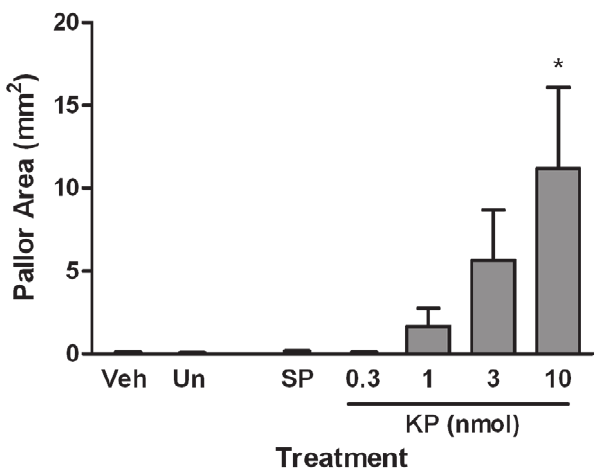
Figure 7. Indomethacin inhibits kisspeptin-induced vasocon- striction. Female CD1 mice were anaesthetised, injected intradermally via the dorsal skin with 5% NaHCO 3 /saline (Veh), 10nmol KP-10 (KP) or 30pmol Endothelin-1 (ET-1) in the presence or absence of 3nmol indomethacin (INDO), each containing an equal amount of 99m Tc. Clearance after ten minutes was assessed and compared to total radioactivity in an uninjected sample. Saline vehicle was adjusted to 100% and results displayed as a % change to controls. Results are shown as mean 6 SEM, N =6. *=p # 0.05 as assessed by one way ANOVA followed by a Bonferroni’s post